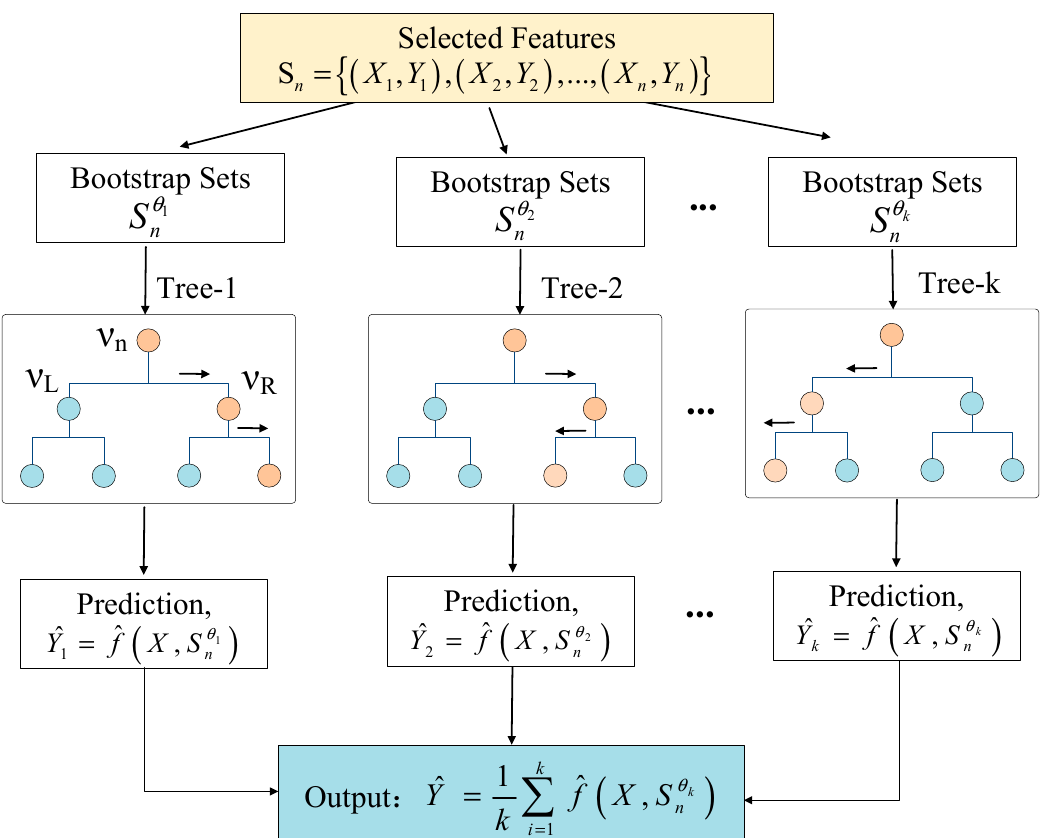
Figure 4. Illustration of Random Forest regression construction.